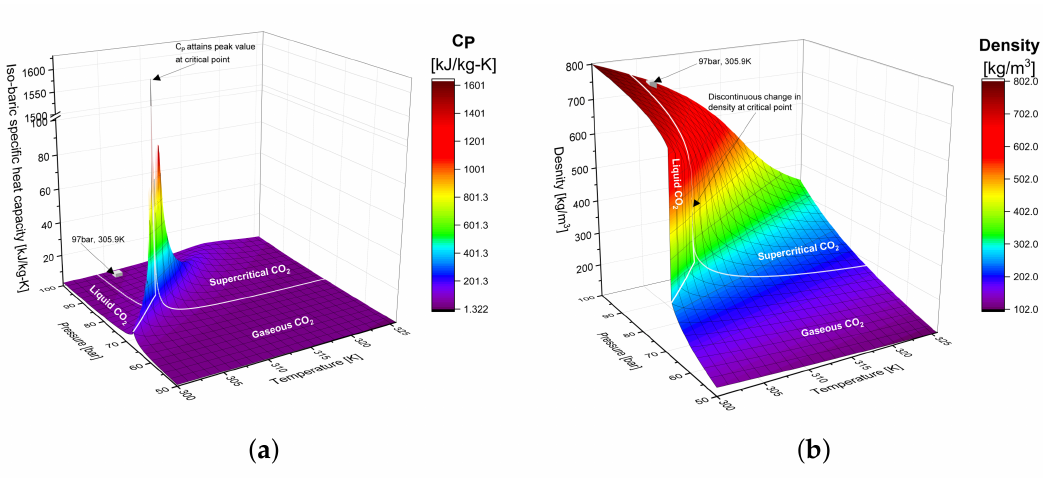
Figure 1. Variation of thermodynamic properties near the critical point. ( a ) Iso-baric specific heat near critical point. ( b ) Variation of density near critical